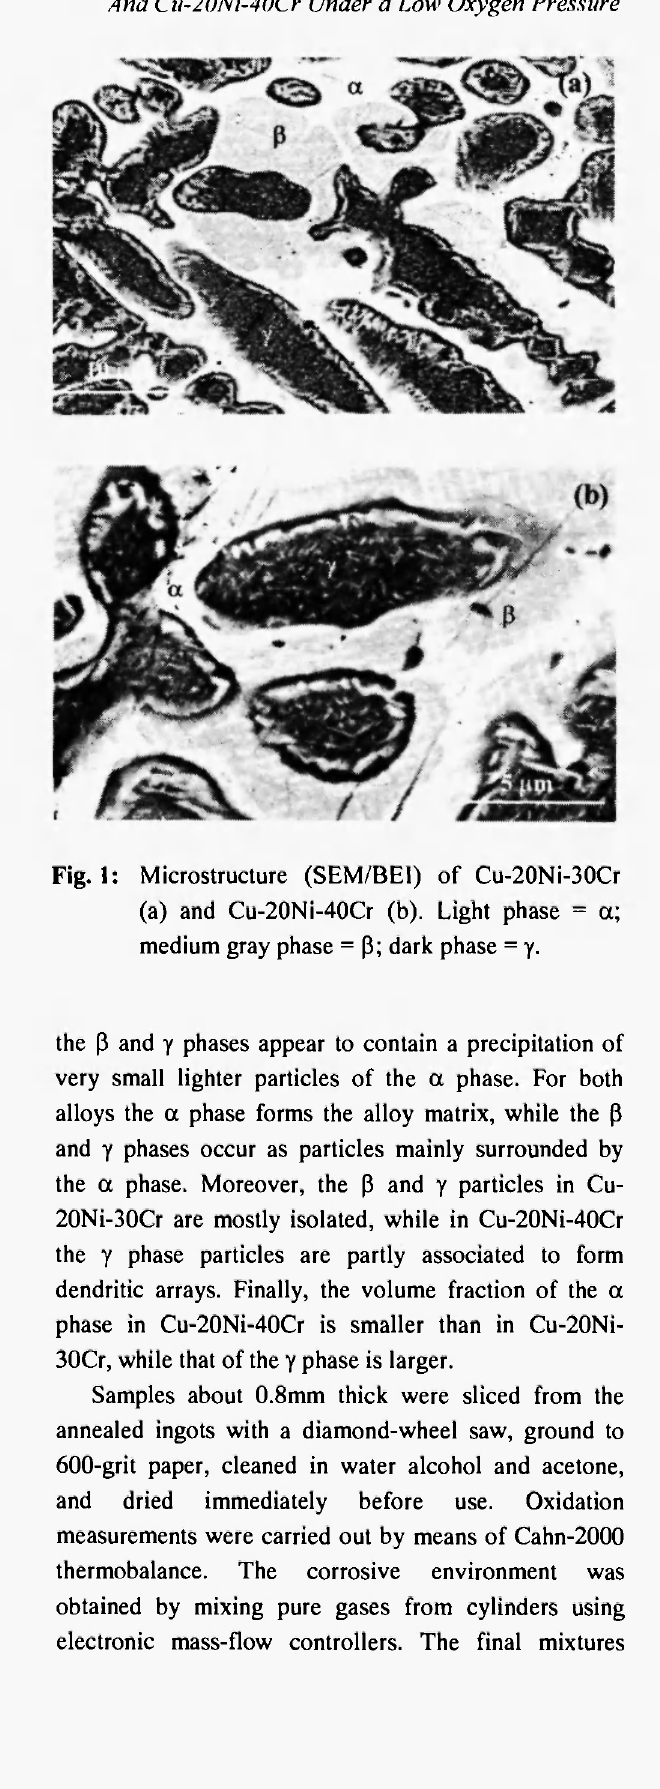
Fig. 1: Microstructure (SEM/BE1) of Cu-20Ni-30Cr (a) and Cu-20Ni-40Cr (b). Light phase = a; medium gray phase = β; dark phase =